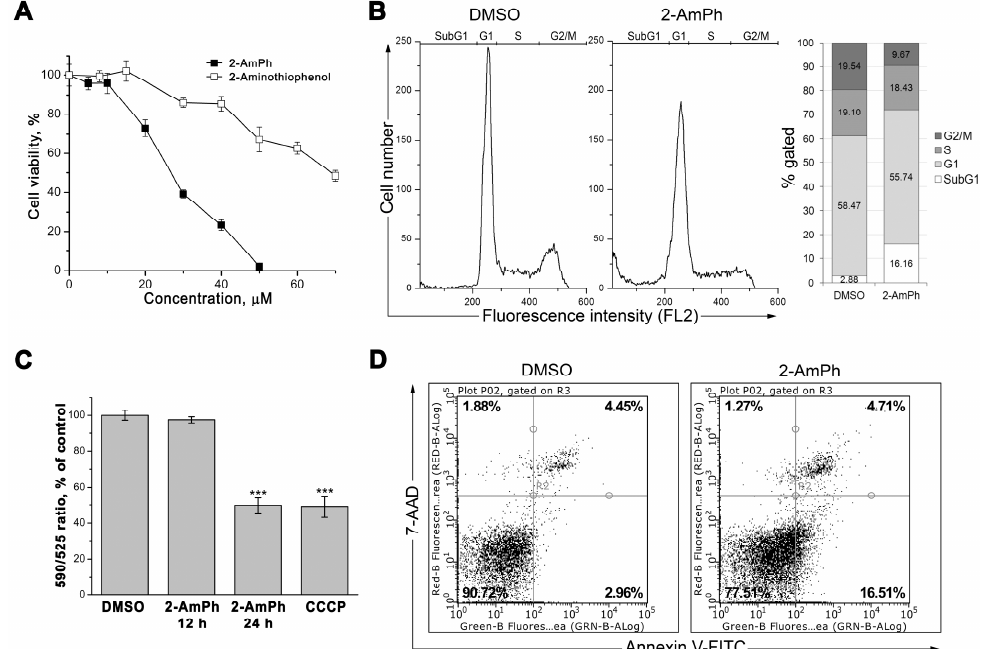
Figure 2. Cytotoxic properties of 2-AmPh for HeLa cells. ( A ) The “dose-effect” curve of MTT staining of cells. ( B ) The cell cycle profiles after PI staining of DNA. ( C ). Decrease in the mitochondrial membrane potential, as revealed from aggregated/monomeric JC-10 staining, *** p < 0.001. CCCP was used as a positive control for the mitochondrial membrane potential loss. ( D ) Flow cytometry analysis of cells stained with Annexin V-FITC conjugate and 7-AAD.